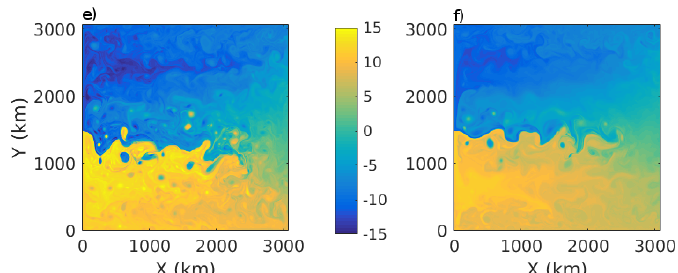
Figure 1. Snapshots from the four configurations. The top four panels show surface vorticity ∇ 2 (units: s − 1 ) from the simulations with ( a ) non-interactive wind stress ( I ); ( b ) wind stress depending only on ocean surface velocity ( II ); ( c ) wind stress depending only on SST ( III ); and ( d ) wind stress depending on both SST and ocean surface velocity ( IV ). The bottom two panels show the QG SST perturbation (units: ◦ C) from the simulations with ( e ) wind stress depending only on SST ( III ); and ( f ) wind stress depending on both SST and ocean surface velocity ( IV ).